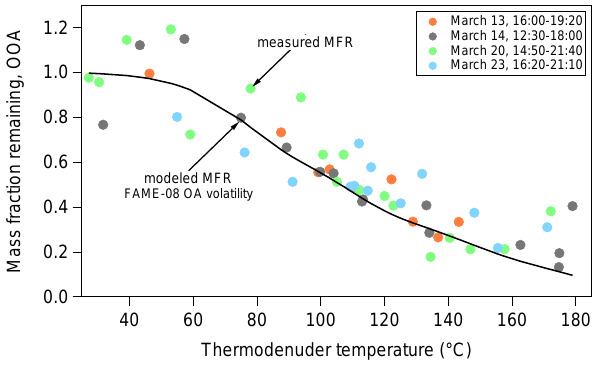
Fig. 11. Measured (circles) and modeled (line) OOA mass fraction remaining (MFR) as a function of thermodenuder temperature. The modeled MFR is obtained using the FAME-08 OA volatility and the aerosol evaporation model. The volatility of the OOA measured during FAME-09 is the same as the volatility of the OA (all OOA) measured during FAME-08.